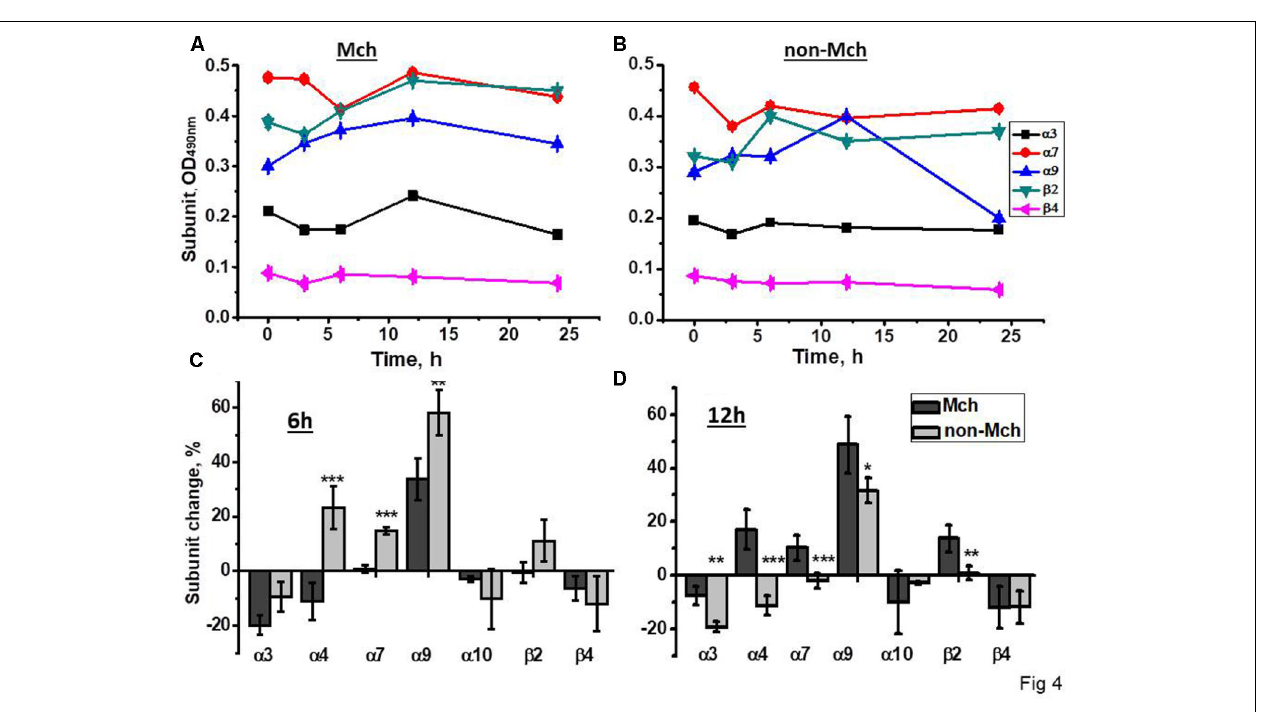
FIGURE 4 | The changes in nAChR subunits content in the mitochondria (Mch) and mitochondria-depleted (non-Mch) liver fractions of rats subjected to LT. (A,B) Absolute OD values, one rat per each time point; (C,D) normalized values for three rats per each time point compared to the section of the liver removed during hepatectomy (mean ± SE). ∗ p < 0.05; ∗∗ p < 0.005; ∗∗∗ p < 0.0005 compared to mitochondrial